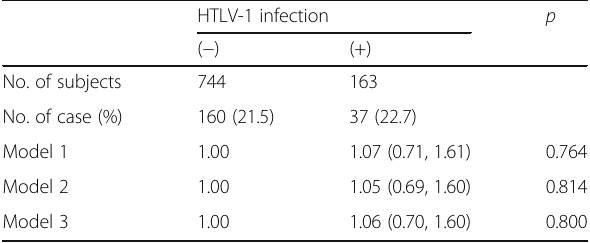
Table 3 Odds ratios (ORs) and 95% confidence intervals (CIs) for advanced periodontitis in relation to human T cell leukemia virus-1 (HTLV-1) infections